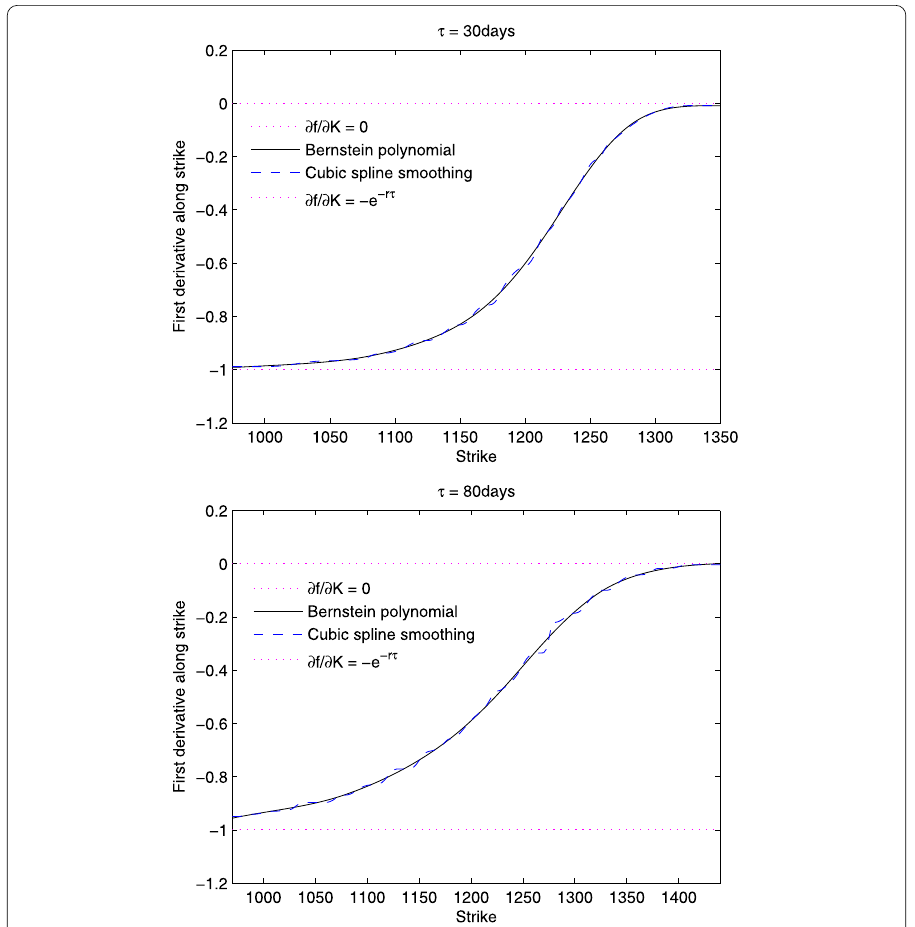
Figure 6 Estimated first derivative of the call price functions in strike. Results are reported for both of the times to maturity of τ = 30 days and τ = 80 days,